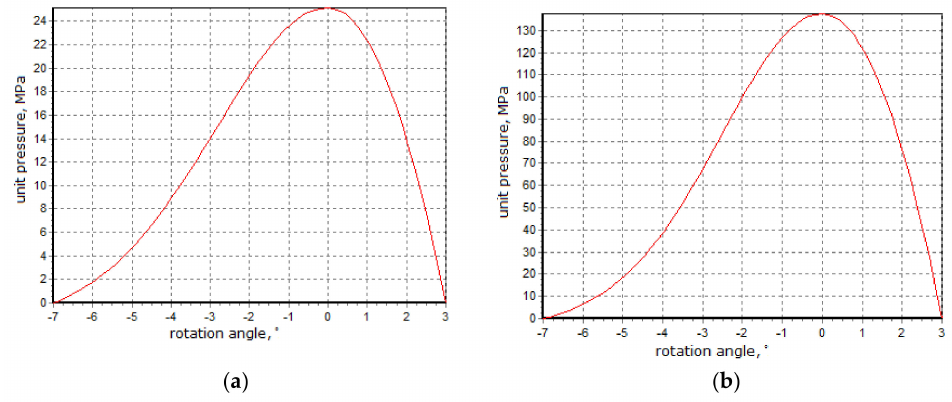
Figure 4. Results of the simulation of the pressure exerted on the bottom of the molding cavity in a press with rollers of a diameter of 1000 mm while briquetting copper concentrates with sulphite lye. ( a ) Regular conditions; ( b ) Extremely unfavorable conditions.